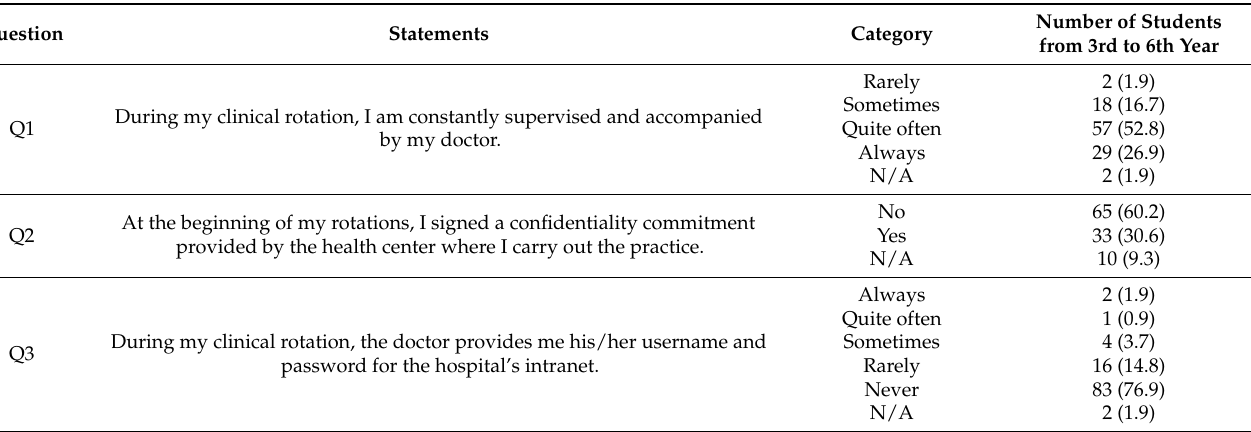
Table 2. Students’ experience when rotating at the hospital. Only students in 3rd–6th years are